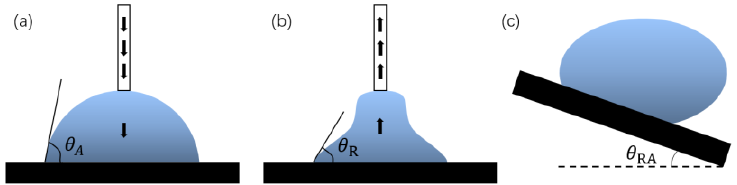
Figure 3. Definition of angles: ( a ) advance angle, ( b ) retraction angle, and ( c ) rolling angle.